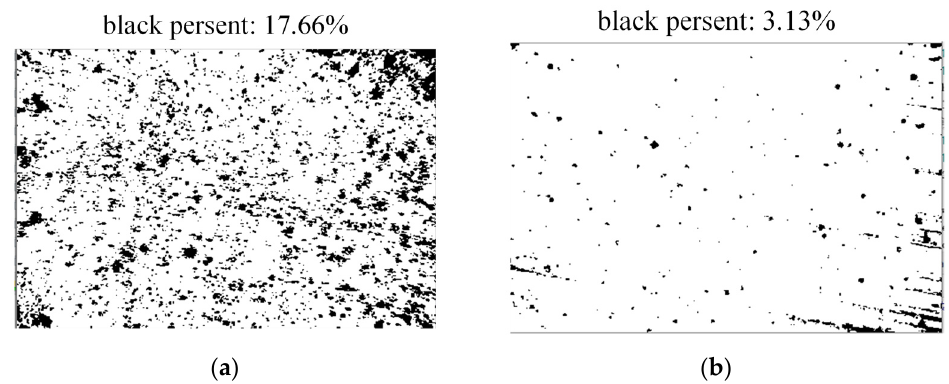
Figure 11. Binarized images with di ff erent scanning speeds: ( a ) 2500 mm/s; ( b ) 2000 mm/s.